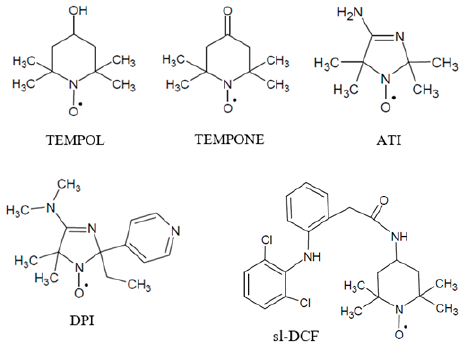
Figure 1. The structures of the paramagnetic compounds.